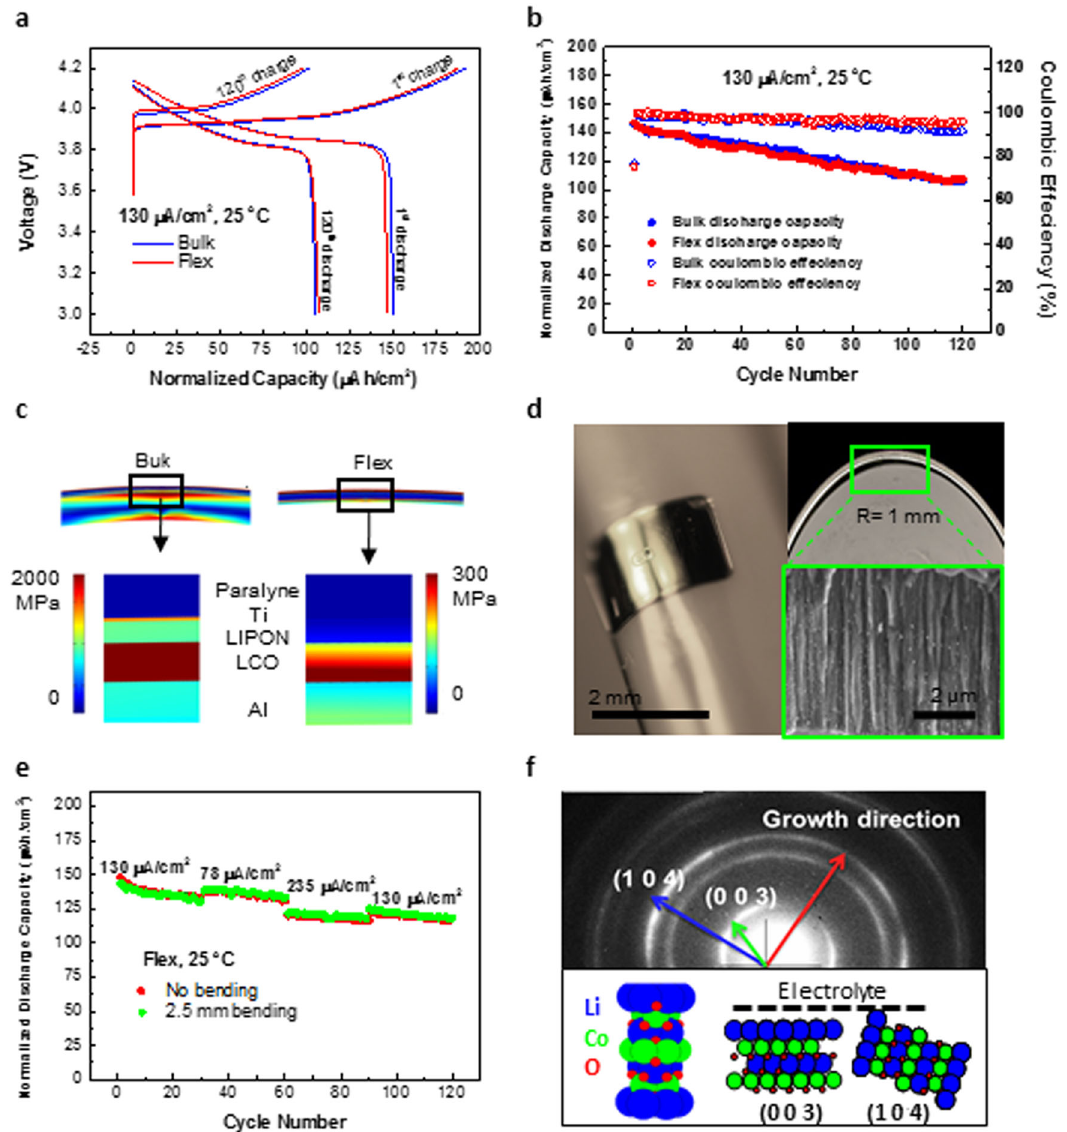
Fig. 3 Mechanical and electrochemical properties of the battery. a Galvanostatic charging and discharging of bulk (blue) and fl exible battery (red) in the 1st and 120th cycle at room temperature and 1 C current rating. b Discharge capacity and calculated coulombic ef fi ciency over 120 cycles during charge and discharge cycles for bulk (blue) and fl exible battery (red) with a limiting charge voltage at 4.2 V and a discharge cutoff voltage at 3 V. c Finite element analysis ( FEA ) of bulk and fl exible battery under 10 mm bending showing simulated less strain simulated values for fl exible battery without Si than the bulk battery with Si d battery under bending optical image and cross section SEM image of fl exible battery under 1 mm bending radius. Zoomed-in photo of fracture-free active cathode battery material showing absence of micro- cracks. e Capacity retention under various current ratings 1 C, 2 C, and 0.5 C, respectively, at room temperature for a fl exible battery under two conditions; (red) fl at with no bending and (green) under 2.5 mm bending. f TEM diffraction pattern image of LCO cathode material exhibiting preferred orientation or texturing and assigned from EDS radial intensity pro fi le (see Supplementary Fig. S6 for peak assignment). Crystal structure of LCO and correlating texturing with lithium-ion diffusion shows that (1 0 4) orientation exhibit higher diffusivity yet strain along the c -axis may increase diffusivity in (0 0 3) oriented